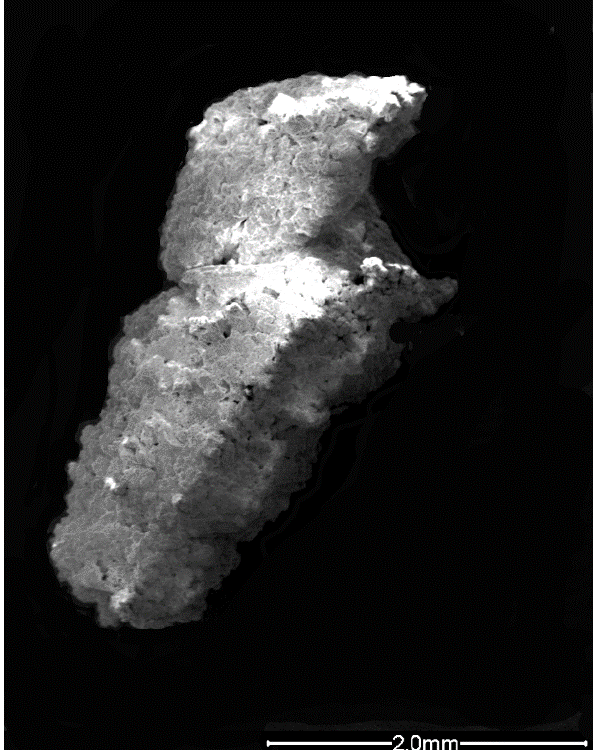
Figure 11. Abyssochrysoid gastropod (IGM 5010b). Line art sketch showing polygonal aperture.